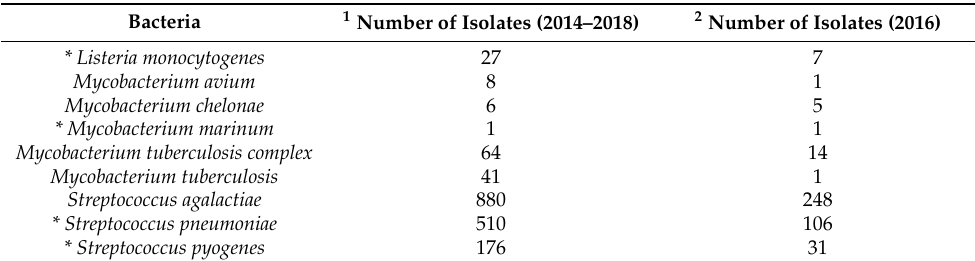
Table 1. Bacteria isolated at HUMV (2014–2018) with GAPDH 90% sequence homology at the N-terminus after a bioinformatic